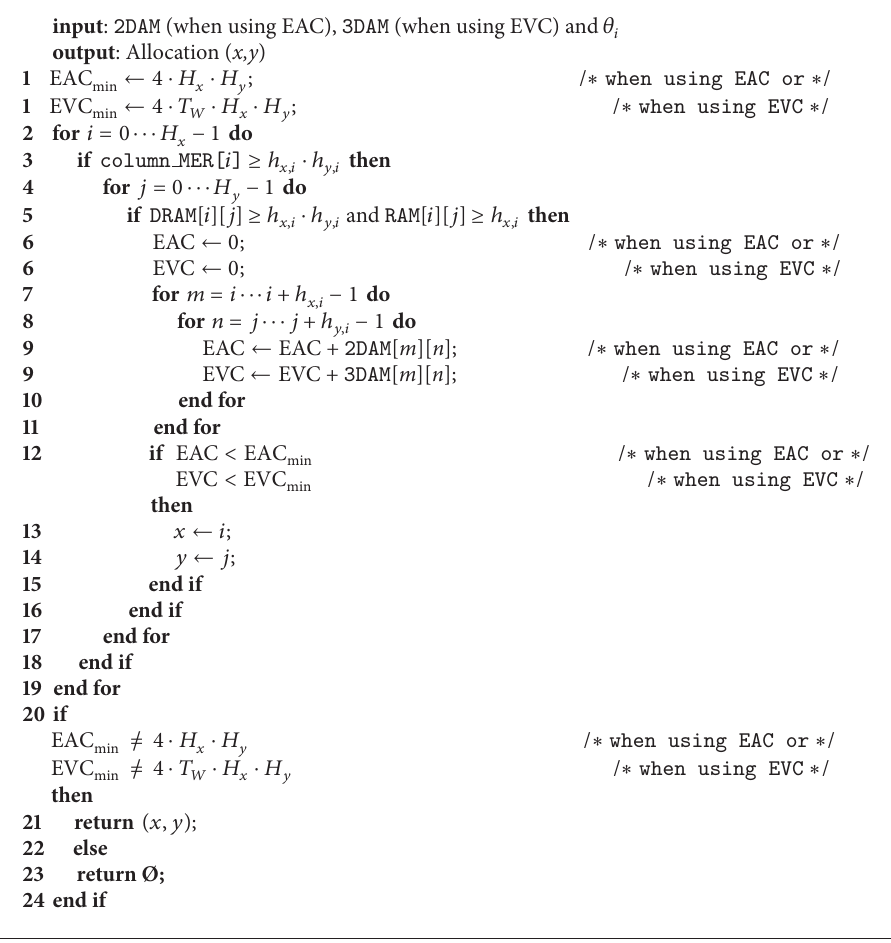
Algorithm 8: Allocation selection based on the EAC and EVC heuristics: Allocate EAC() and Allocate EVC()